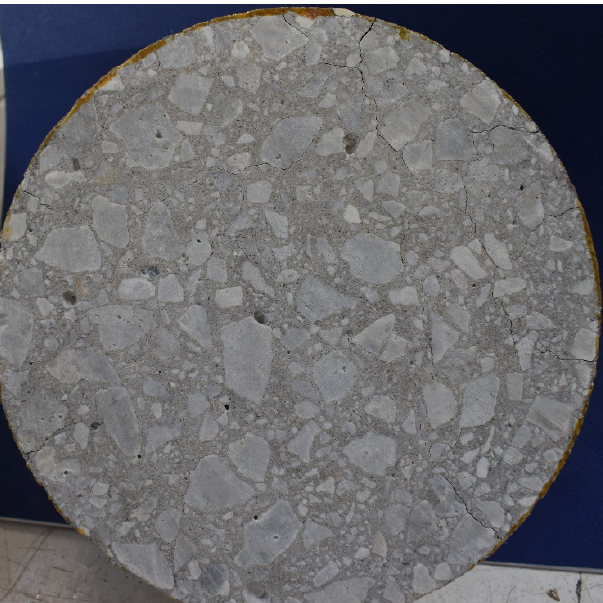
Figure 8. Detrimental cracking of a cylindrical concrete specimen with 30% wood fly ash (as a cement replacement) containing 57.6% CaO (results of a previous study [82]). replacement) containing 57.6% CaO (results of a previous study